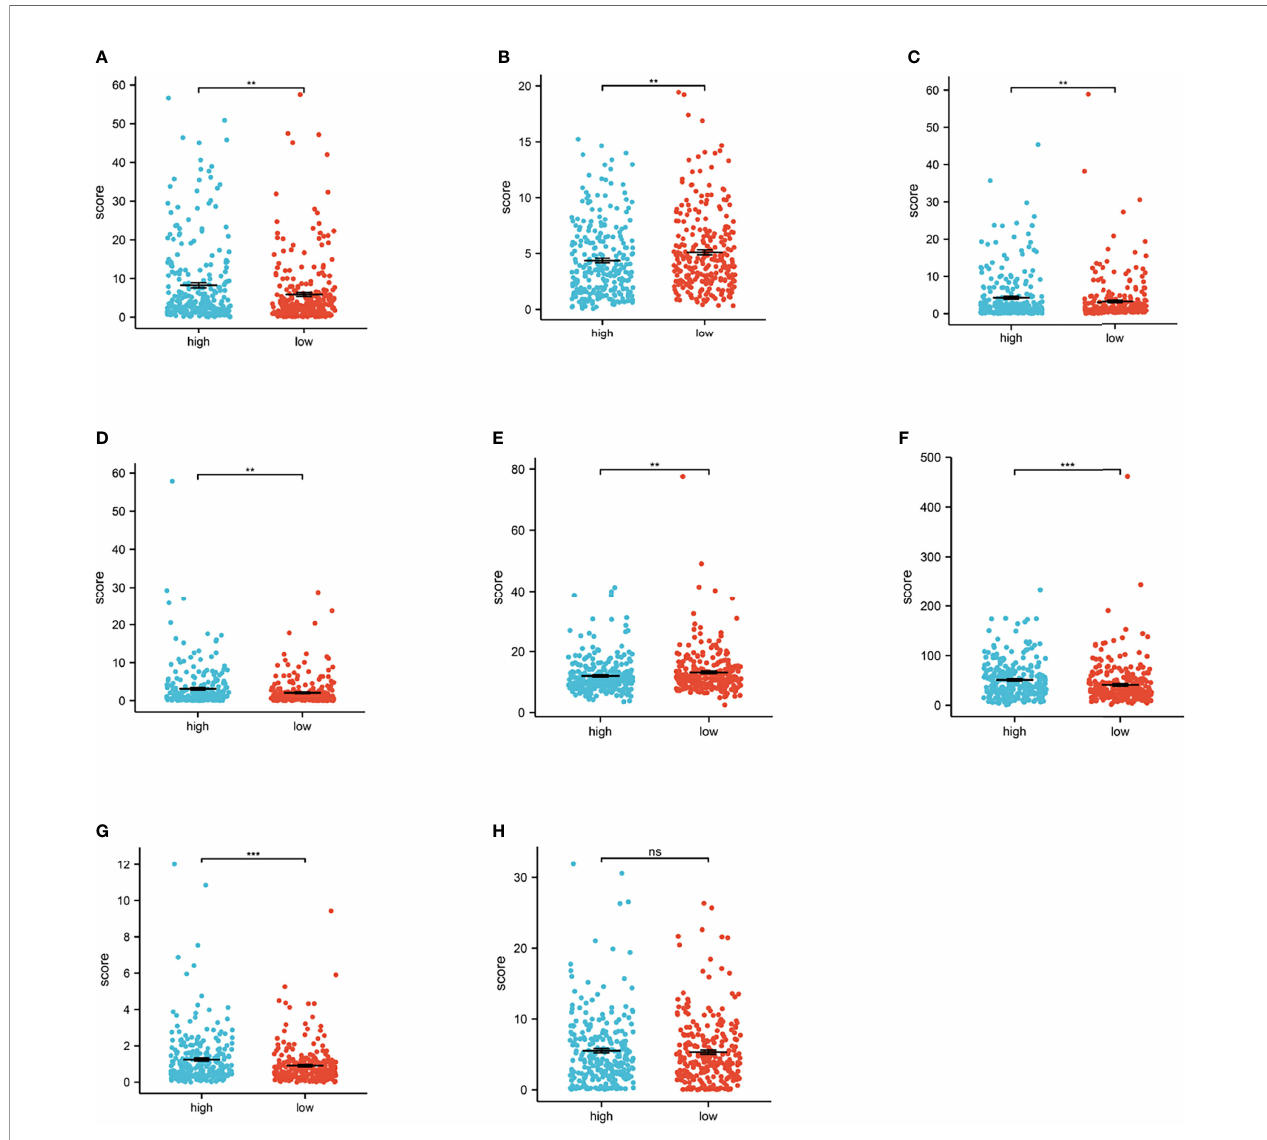
FIGURE 7 | Relationship between risk score and immune checkpoint. (A – H) High-risk scores were positively correlated with high expression of CD27 ( p < 0.01, Figure 6A ), LAG3 ( p < 0.01, Figure 6C ), PDCD1 ( p < 0.01, Figure 6D ), and TNFRSF12A ( p < 0.01, Figure 6F ), TNFRSF18 ( p < 0.001, Figure 6G ) and low expression of CEACAM1 ( p < 0.01, Figure 6B ) and PVR ( p < 0.01, Figure 6E ), while TNFSF9 ( Figure 6H ) shows no statistical signi fi cance (* p < 0.0, ** p < 0.001, *** p <